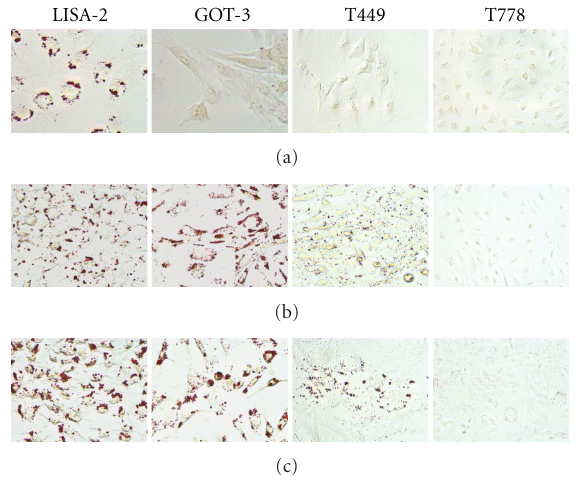
Figure 3: Adipocytic di ff erentiation potential of the LPS cell lines. Shown is oil red O staining of lipid-containing vacuoles in cells during (a) logarithmic growth in normal cell culture medium (basal di ff erentiation status), (b) high cell density growth for 10 days in normal cell culture medium (spontaneous di ff erentiation potential), (c) high cell density growth for 10 days in adipocytic di ff erentiation medium (induced di ff erentiation